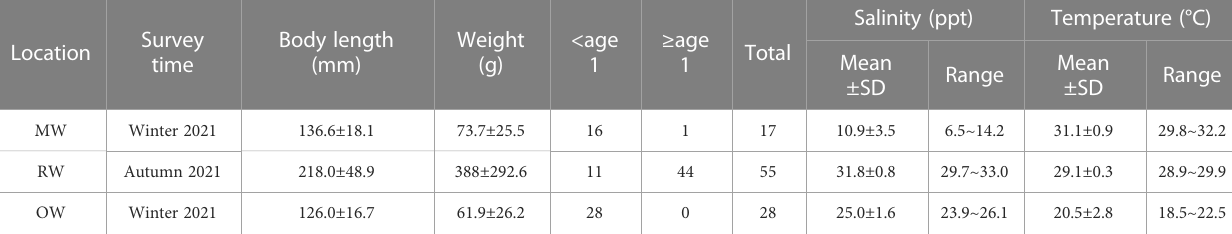
TABLE 1 Descriptive statistics of A. latus and bottom seawater salinity and temperature at sampling sites.